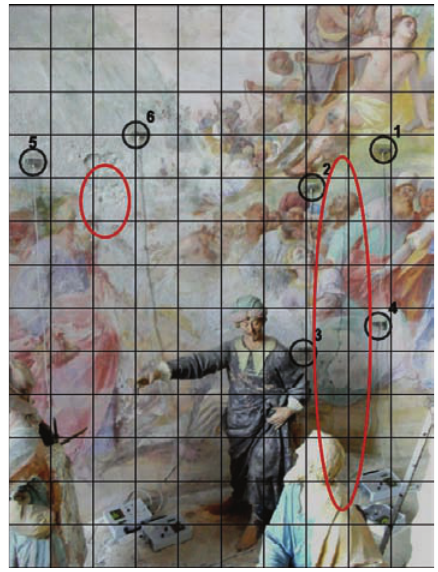
Figure 5: Chapel XVII. View of the monitored areas. Left side: sensors 5, 6, and the frescos detachment. Right side: sensors 1–4 and the vertical